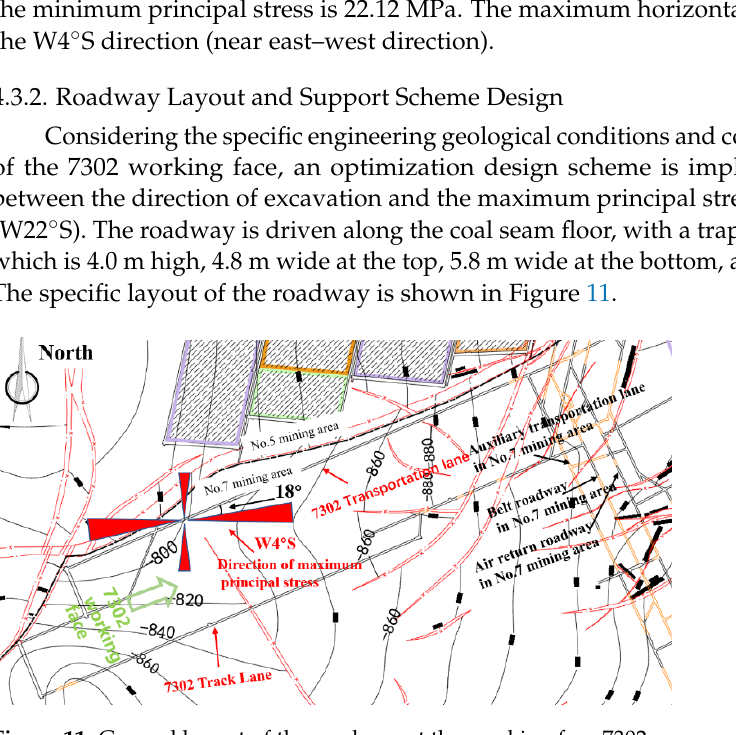
Figure 11. General layout of the roadway at the working face 7302.